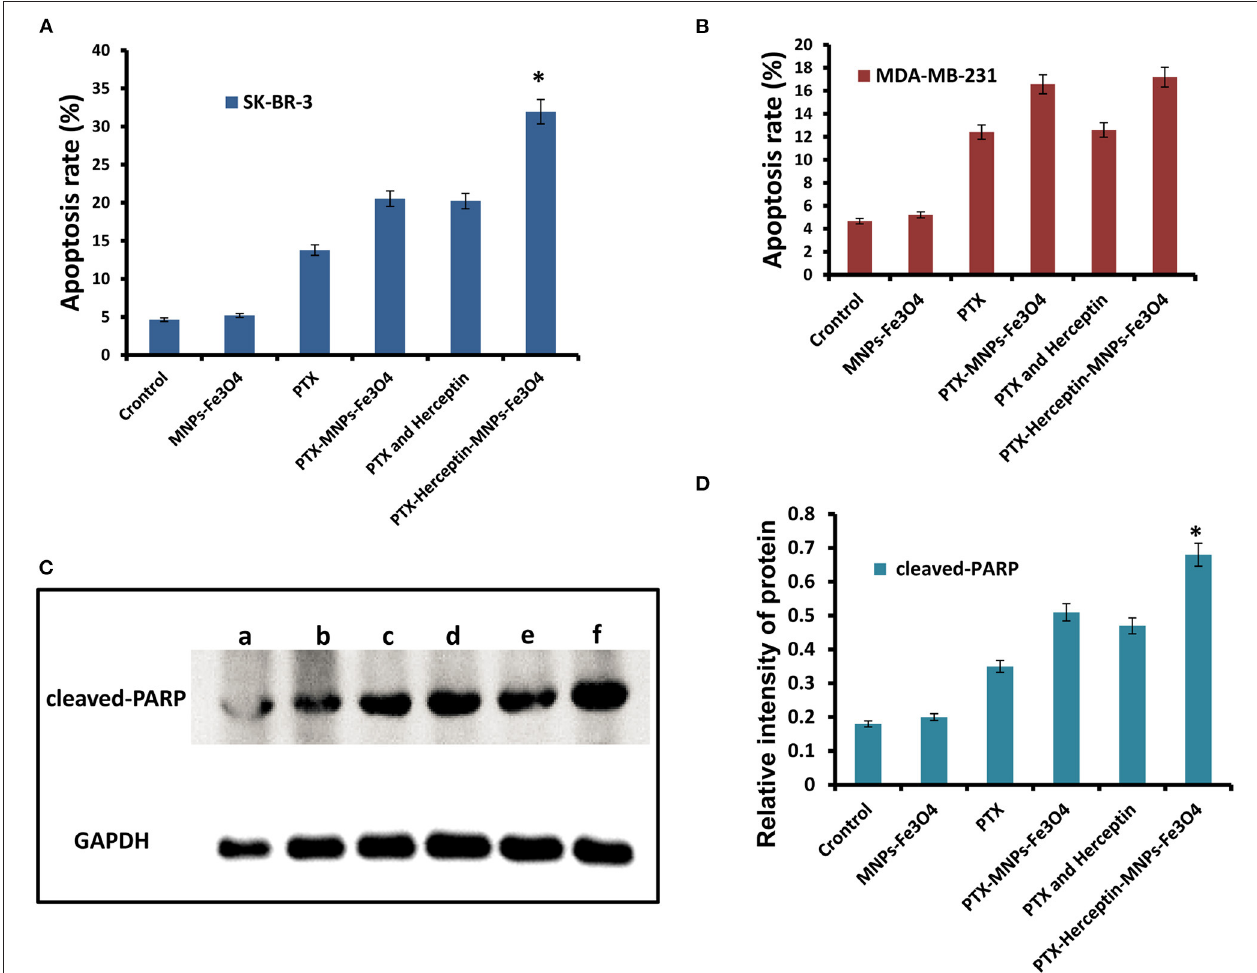
FIGURE 3 | (A) Apoptosis rate of SK-BR-3 cells in different groups. (B) Apoptosis rate of MDA-MB-231 cells in different groups. (C) Levels of cleaved-PARP (a, Control group; b, MNPs-Fe 3 O 4 group; c, PTX group; d, PTX-MNPs-Fe 3 O 4 group; e, PTX and Herceptin group; and f, PTX-Herceptin-MNPs-Fe 3 O 4 group) and (D) relative intensity of cleaved-PARP in SK-BR-3 cells after treatment in different groups. * P < 0.05 when compared with the PTX and Herceptin group.